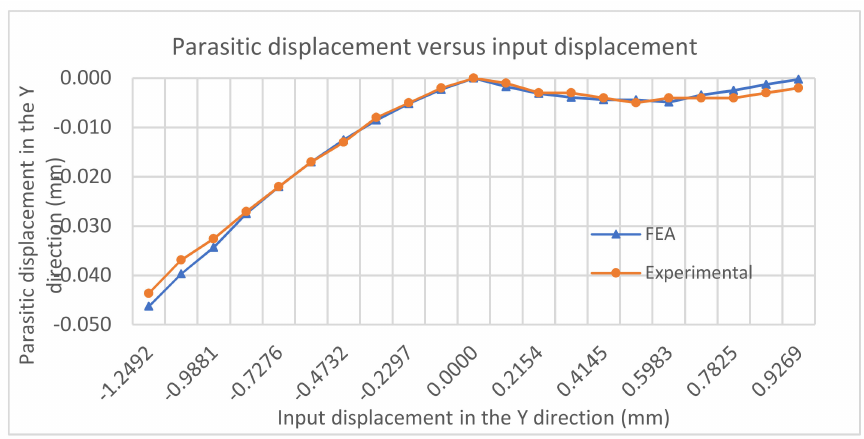
Figure 12. Parasitic motion in the Y